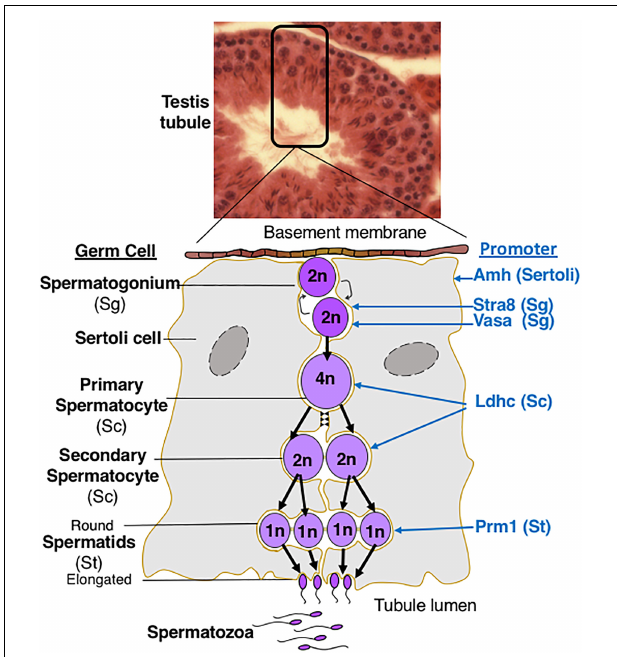
FIGURE 3 | Spermatogenesis in Mammals. The diagram describes germ cell differentiation during spermatogenesis and identifies the germ cell type in which different promoters are active. 2n diploid; 4n, tetraploid; 1n